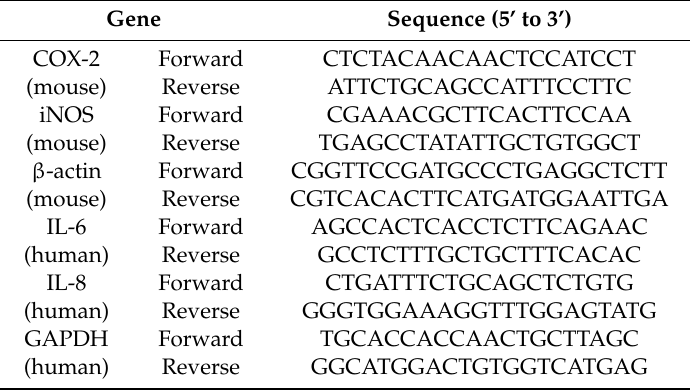
Table 1. Primer sequences used for real-time